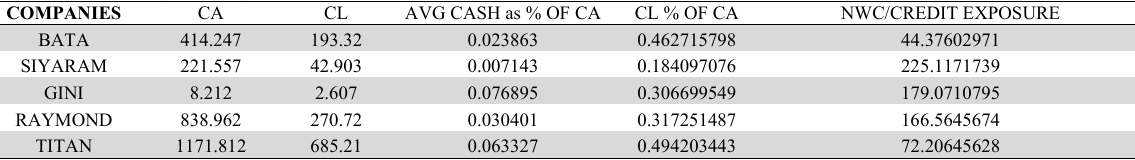
Analysis of Liquidity position of Retail Sector